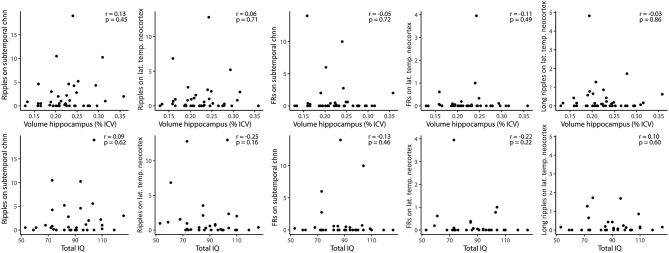
Correlations between HFO rates and volume of resected hippocampus (upper row), and HFO rates (subtemporal and lateral temporal neocortical channels) and total pre-resection IQ (lower row). None of the Spearman correlations was significant. FRs, fast ripples; Chnn, channel; lat., lateral; temp., temporal.